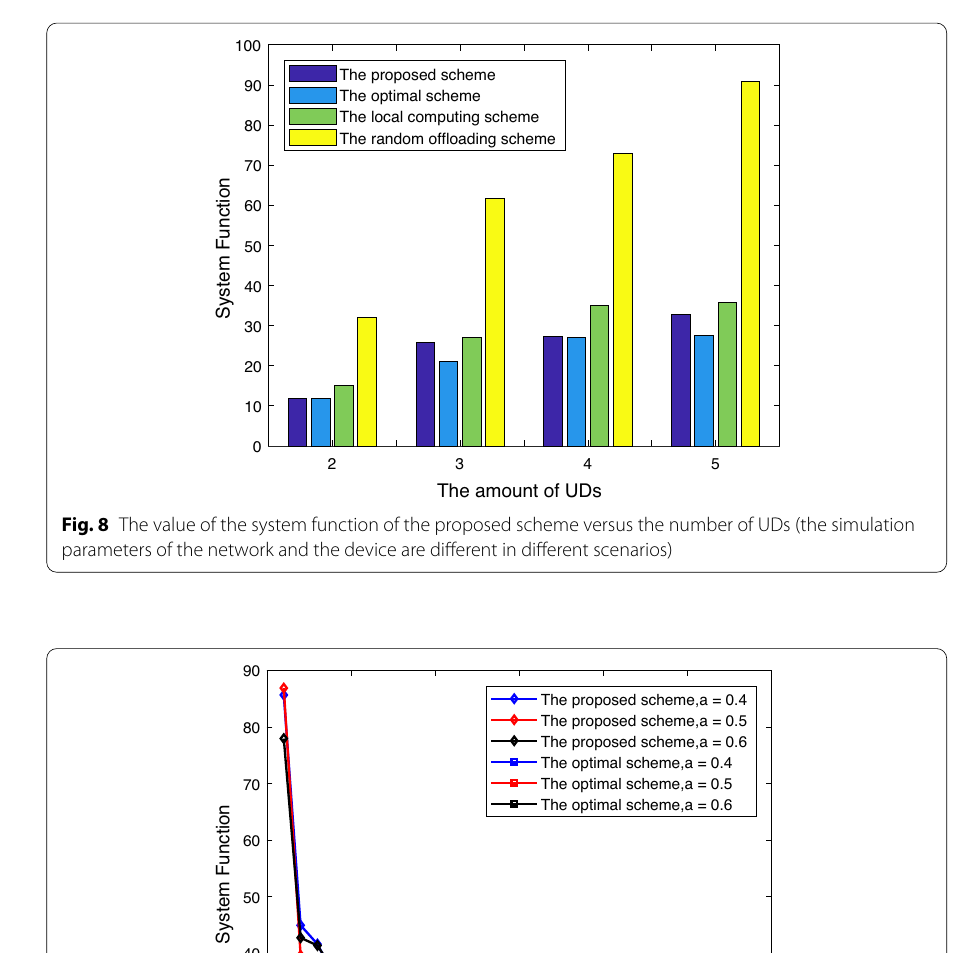
The proposed scheme,a = 0.4 The proposed scheme,a = 0.5 The proposed scheme,a = 0.6 The optimal scheme,a = 0.4